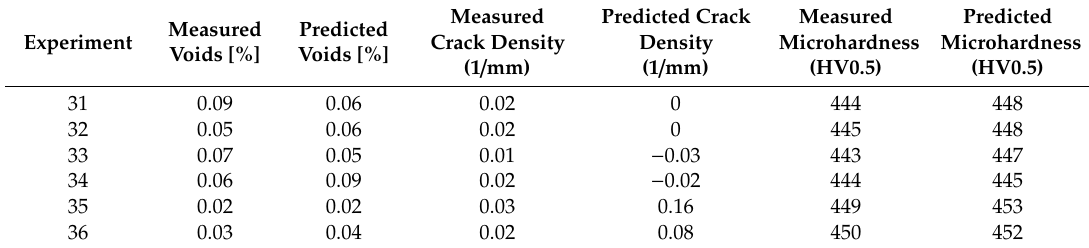
Table 5. Measured and calculated values of the additional six